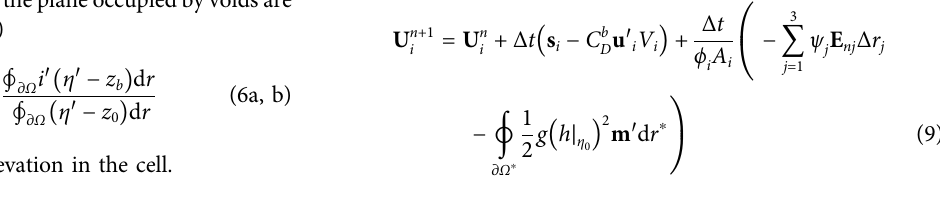
Frontiers in Earth Science |